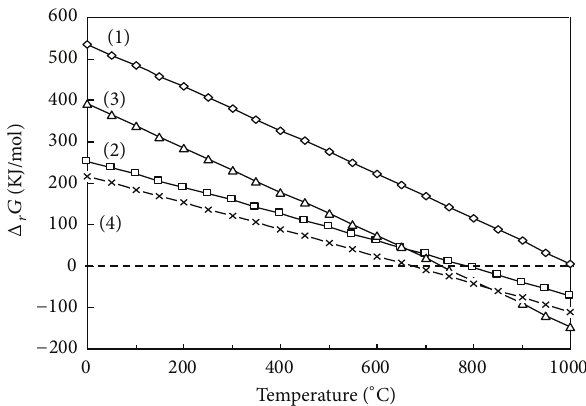
Figure 2: Thermodynamic calculations for the possible reactions between methane and CeO 2